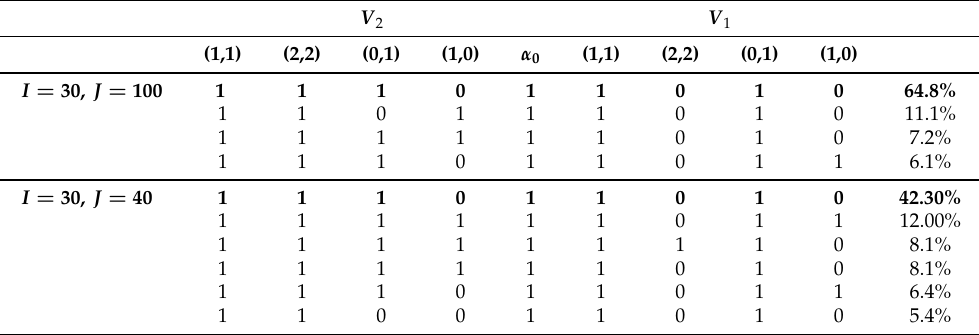
Table 1. Model selection: Monte-Carlo assessment of relative performance of the selection method across data sizes based on 1000